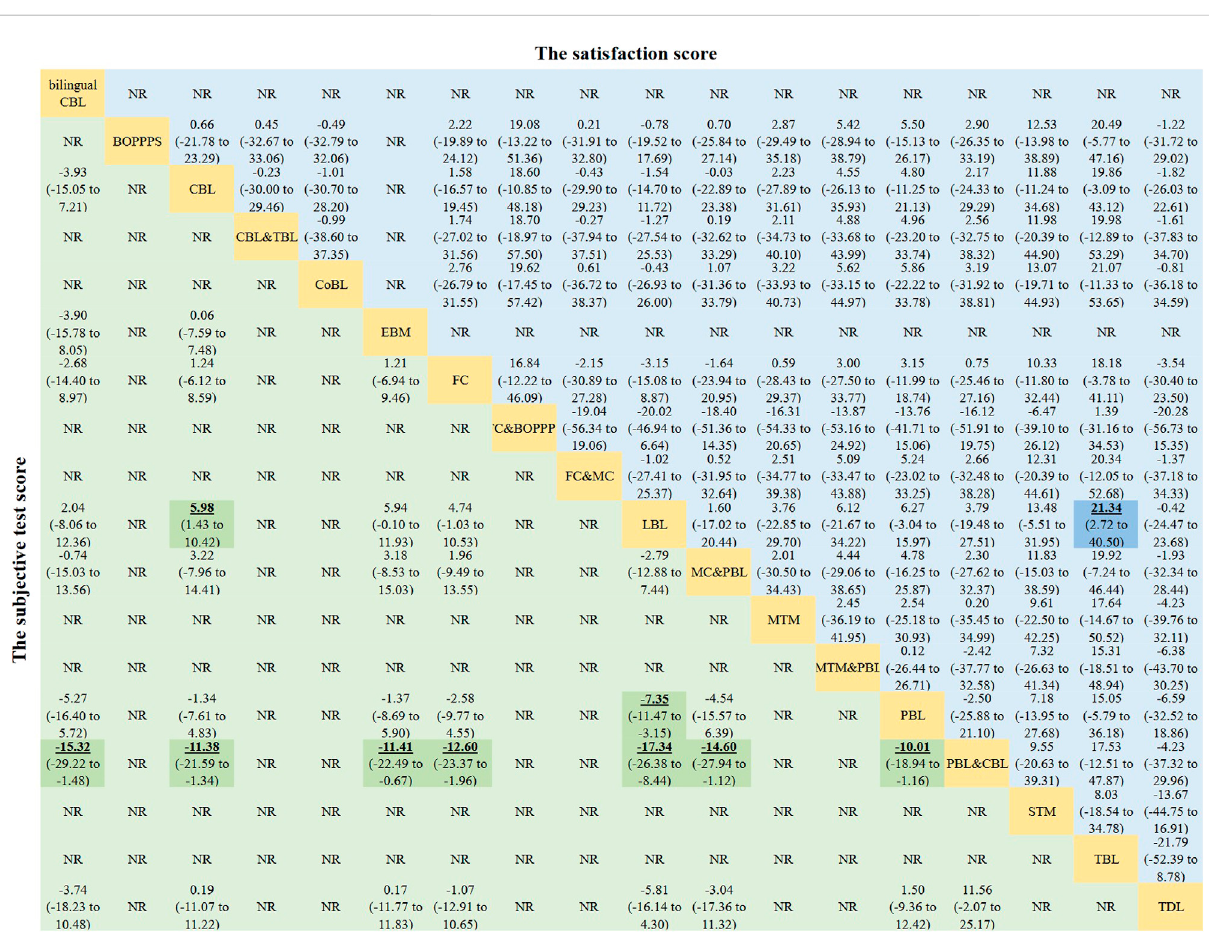
FIGURE 5 Mean differences of the subjective test score (lower triangle) and the satisfaction score (upper triangle). Data with mean differences represent the comparison of row-de fi ning method versus column-de fi ning method. Data in parentheses are the 95% credible intervals. Mean differences more than zero favour the column-de fi ning method. Signi fi cant results are highlighted in bold, underline, and background fi ll. NR represents this indicator was not reported in this method among the included